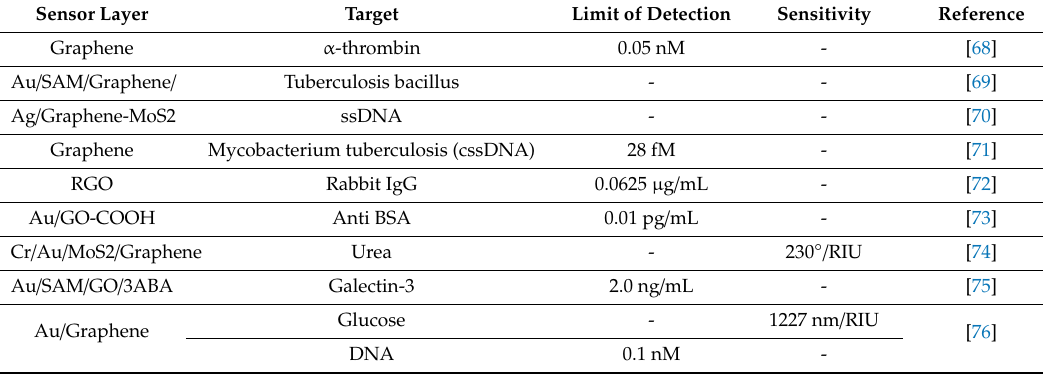
Table 1. Graphene- surface plasmon resonance (SPR)-based materials in biological